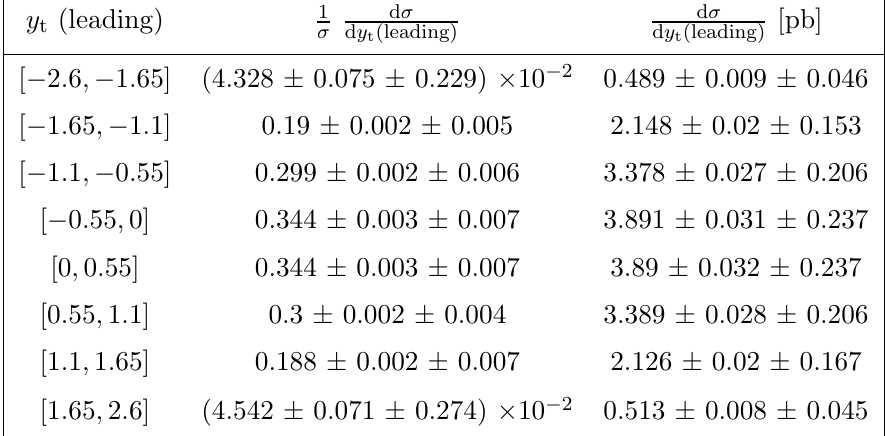
Table 22 . The measured di(cid:11)erential cross section and bin boundaries for each bin of the normalized and absolute measurements of the tt di(cid:11)erential cross section at particle level in the (cid:12)ducial phase space as a function of y t (leading) are tabulated.